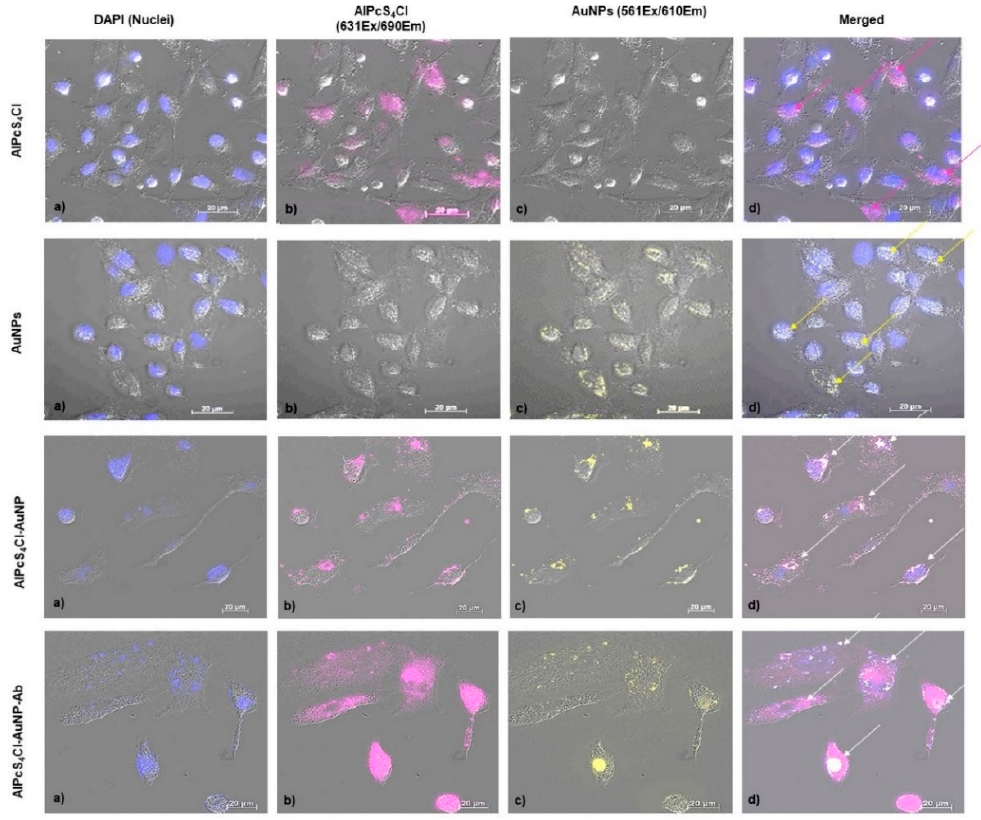
Figure 7. FL and DIC composite imaging of cellular localization of the NBC molecules and compounds in lung CSCs. ( a ) DIC imaging of lung CSCs, where cell nuclei are stained blue, using DAPI, ( b ) AlPcS 4 Cl auto fluorescence, ( c ) AuNPs auto fluorescence ( d ) and merged images of the reciprocal localization of the single NBC components in their different conjugation modes.